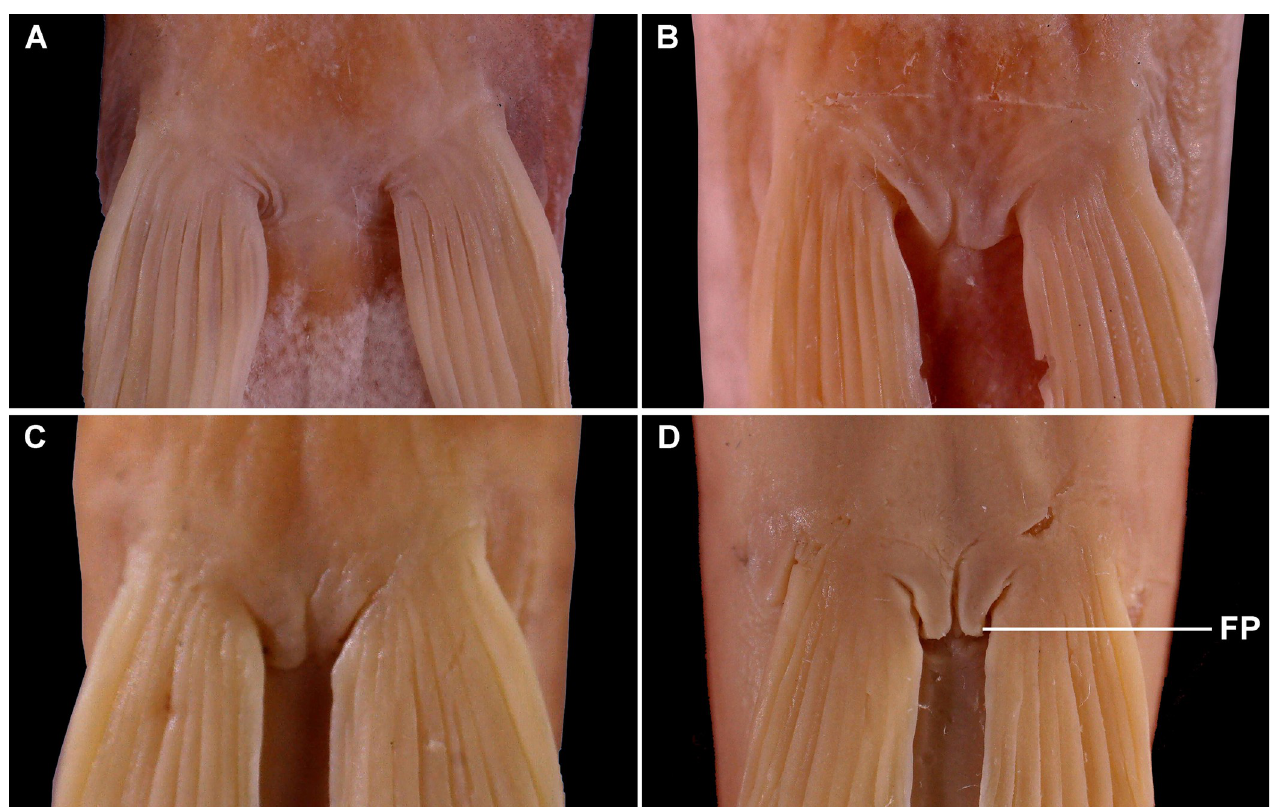
Fig 3. Ventral view of pelvic plate of Homatula from the upper Mekong River, China. (A) H . geminusclathratus , holotype SWFU 0309250, 131.8 mm SL; China: Yunnan Prov.: Pu’er City: Jingdong Co.: Wenjing Town. (B) H . longibarbatus , holotype SWFU 0309082, 107.3 mm SL; China: Yunnan Prov.: Dali Pref.: Yangbi Co.: Pingpo Town. (C) H . microcephala , holotype SWFU 0612057, 90.2 mm SL; China: Yunnan Prov.: Dali Pref.: Yunlong Co.: Jiancao Town. (D) H . pycnolepis , SWFU 0612085, 99.6 mm SL; China: Yunnan Prov.: Dali Pref.: Yunlong Co.: Xiangtu Town. (FP: A muscular protrusion in body surface at the pelvic